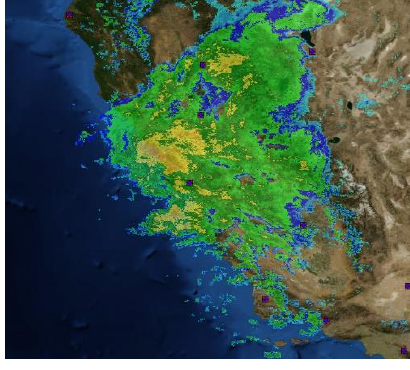
Figure 2. Composite radar for SFBA on 20 February 2017 at 1055Z. See [16] for definition and description of product.